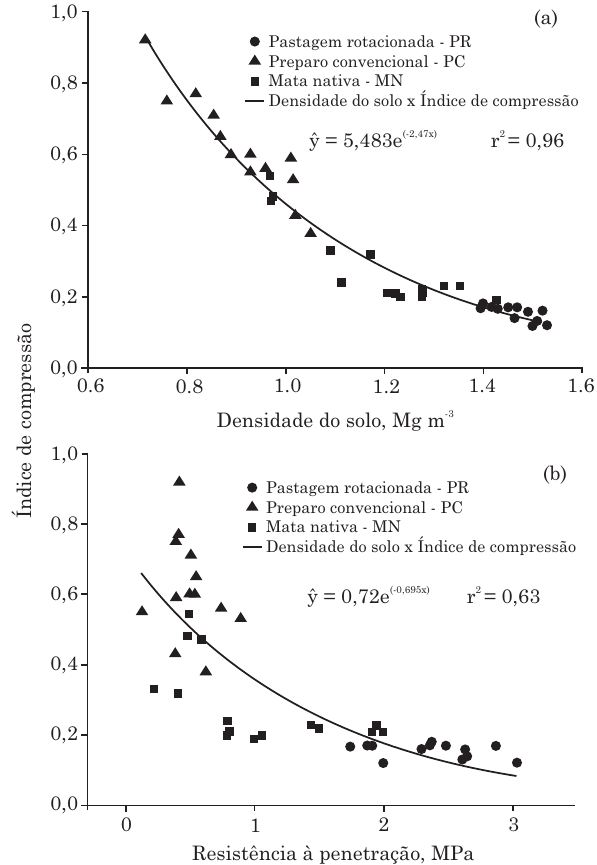
Figura 3. Relação entre o índice de compressão e densidade do solo (a) e resistência à penetração (b), em três sistemas de uso do solo.